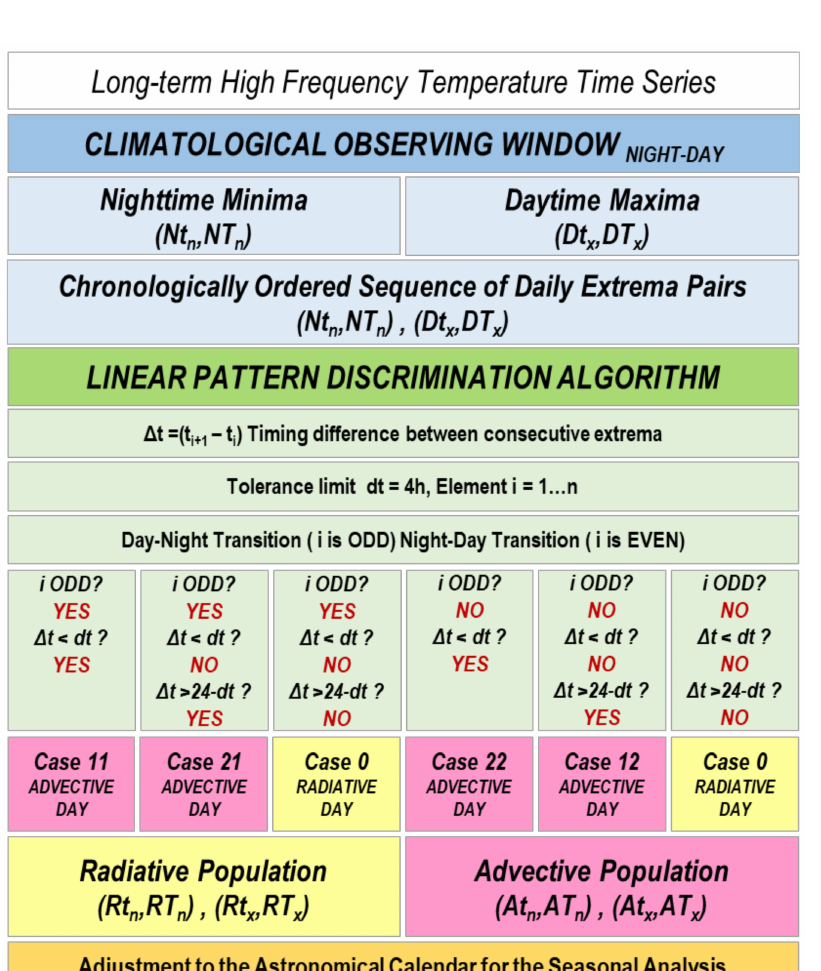
Figure 3. Steps for identification of daily mathematical extrema and partitioning of radiative and advective temperature